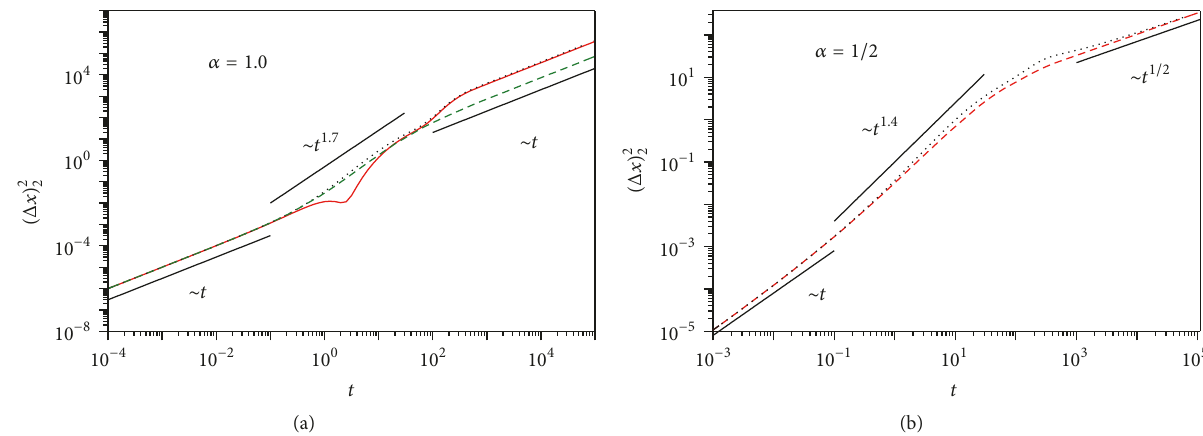
Figure 3: This figure illustrates the behavior of the mean square displacement for species 2 versus 𝑡 . In (a) the black dotted line corresponds to the cases K 1 = K 2 = 1 , 𝜅 = 1 , 𝜏 = 1 , and 𝑘 = 0.01 . The green dashed line is the case K 1 = K 2 = 1 with 𝜅 = 0 and the red line is the cases K = 1 , K = 3.5 , 𝜅 = 1 , and 𝜏 = 1 with 𝑘 = 0.01 . In (b) the black dotted line is the case 𝜅 = 1 and the blue solid line corresponds to 𝜅 = 0 , 1 2 respectively. For these cases, we used K 1 = K 2 = 1 , 𝜏 = 1 , and 𝑘 = 10 −2 . We also use straight lines to evidence the different behavior of the mean square